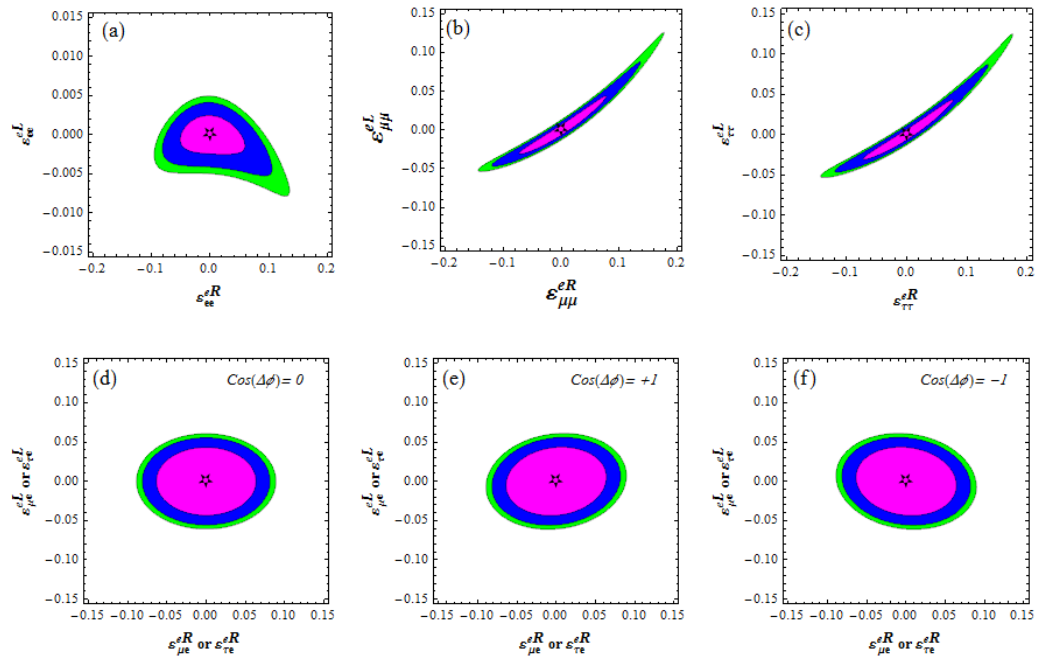
Figure 7 . Future prospects: allowed 68% (magenta), 90% (blue) and 95% (green) C.L. NSI bound- aries are shown for the detector-only case. By de(cid:12)nition of the \data" and the (cid:31) 2 , the best-(cid:12)t value, indicated by the star, is at the origin in each